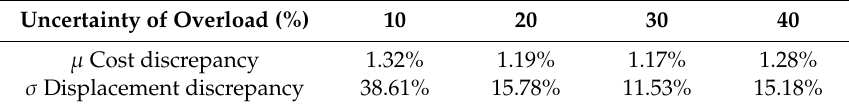
Table 6. Validation of the kriging surfaces varying the overload.